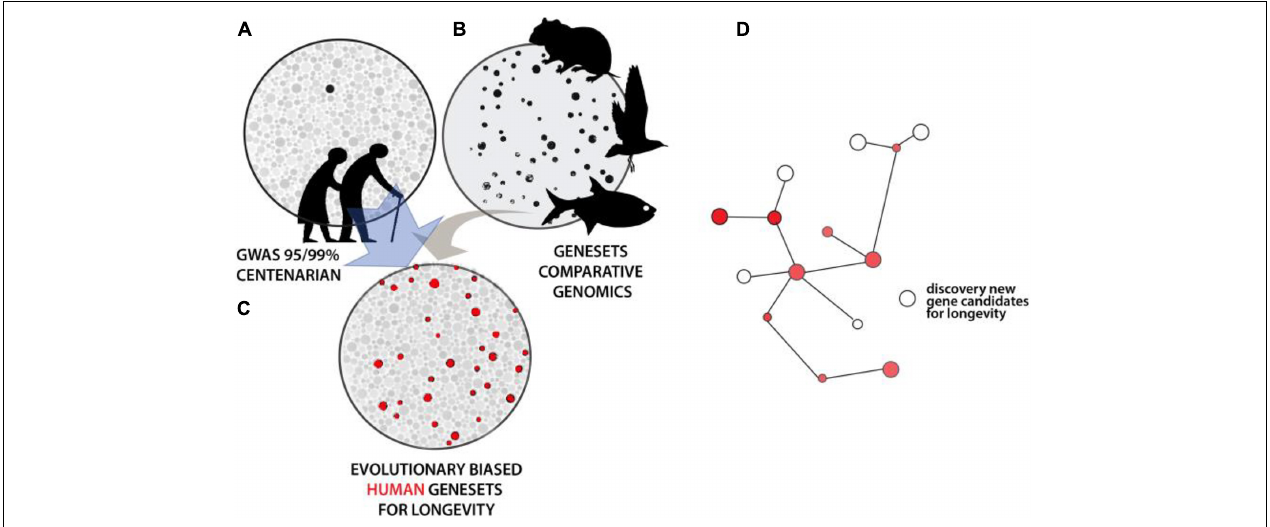
FIGURE 3 | Intersectional analysis to identify conserved genetics of lifespan regulation. (A) Illustrative depiction of statistical resolution of genetic association analysis across older human populations and/or long-lived individuals. Strength of shading and size represents level of statistical strength on pathway or gene. Black represents those groups significant at above FDR corrected values. (B) Convergence analysis within and across lineages defining broad Gene Sets. (C) Using comparative gene sets to focus statistical analysis of human variation reveals broader statistical association within this smaller set (red). These processes or genes underlying these traits are conserved. (D) Analysis of hits within known pathways or genetic interactive maps permits flushing out other potential regulators not directly altered in particular lineages.